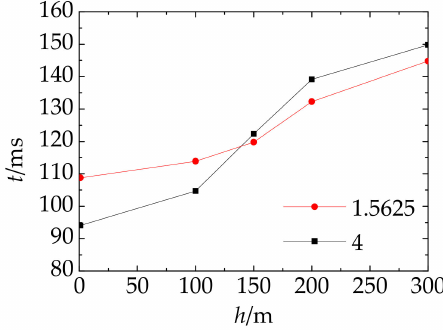
Figure 8. Transition to steady state cone (100 m, expansion ratio of 1.5625).